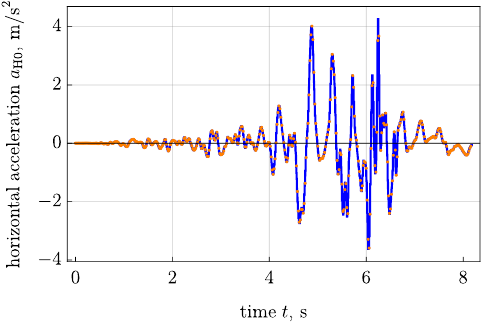
Figure 3. Horizontal acceleration over physical time t for Kobe earthquake data interpolated with Mathematica (an initial data segment with largest accelerations is shown). The orange points denote the Kobe earthquake data and the blue curve is for the interpolated function.